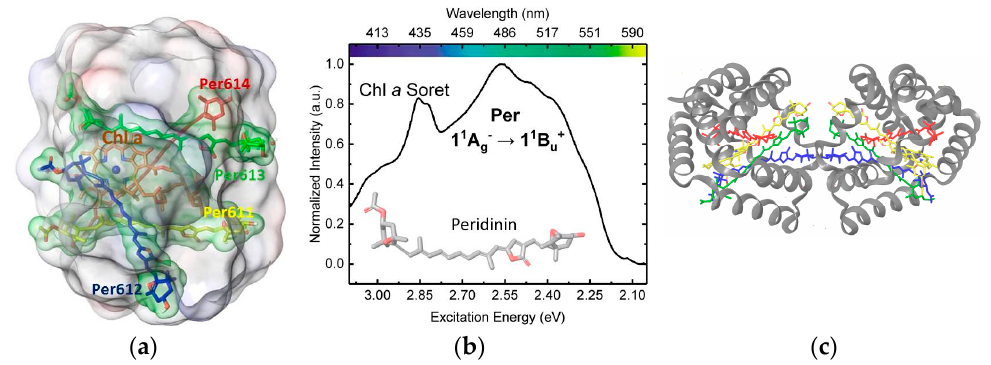
Figure 1. ( a ) Partial view of the cofactor cluster inside a single domain of the reconstituted, recombinant peridinin-chlorophyll a protein (RFPCP) complex. Highlighted in green is the supramolecular assembly consisting of four bound peridinin (Per) molecules and one chlorophyll a (Chl a ) encapsulated by the van der Waals surface of the protein. ( b ) Absorption spectrum of the peridinin-chlorophyll a protein (PCP) complex (ref. [4]) and chemical structure of Per. ( c ) Full view of the RFPCP C 2 -symmetric homodimer.